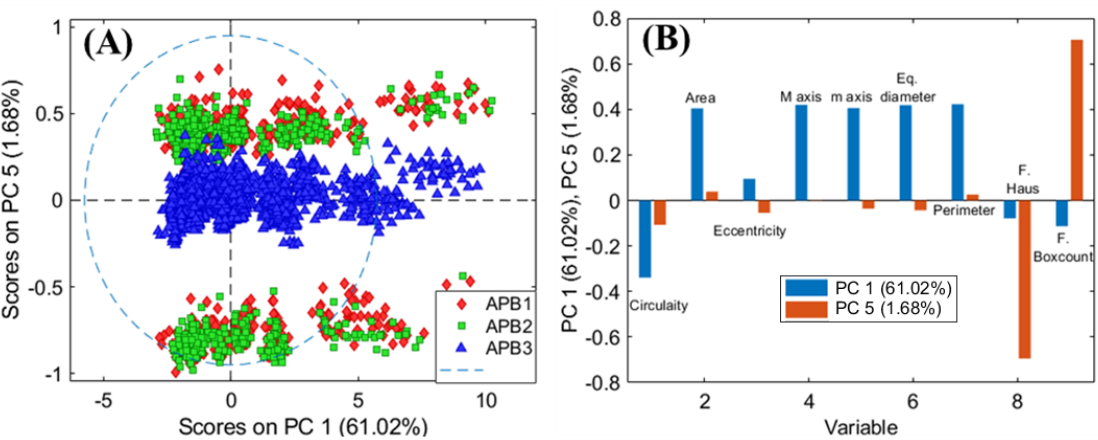
Figure 4. PCA score plot of PC1 and PC5 ( A ), and loadings ( B ) showing the variability of each selected parameter for the samples APB1, APB2, and APB3.